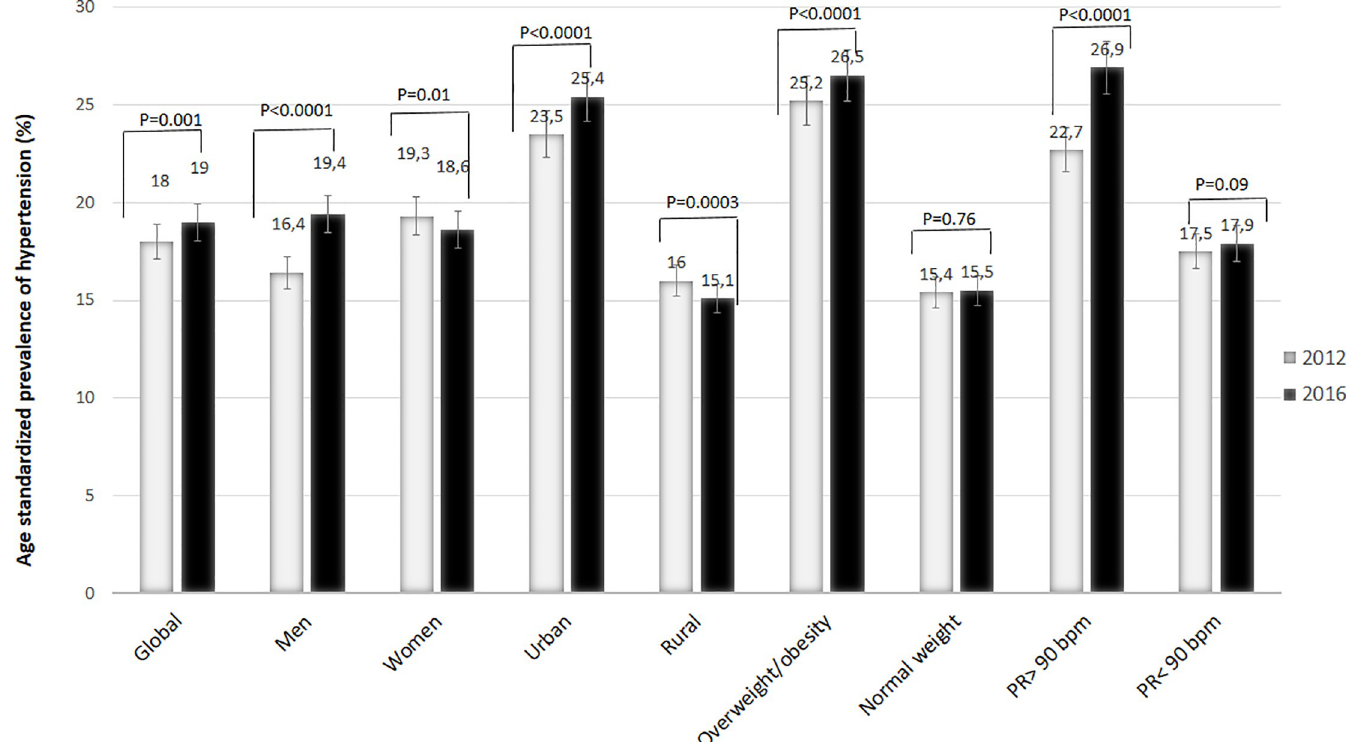
Fig 3. Distribution of hypertension in 2012 and